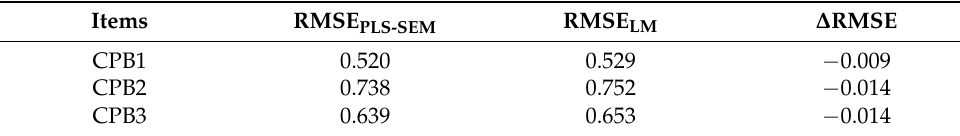
Table 5. PLSpredict assessment of the manifest variable CPB.